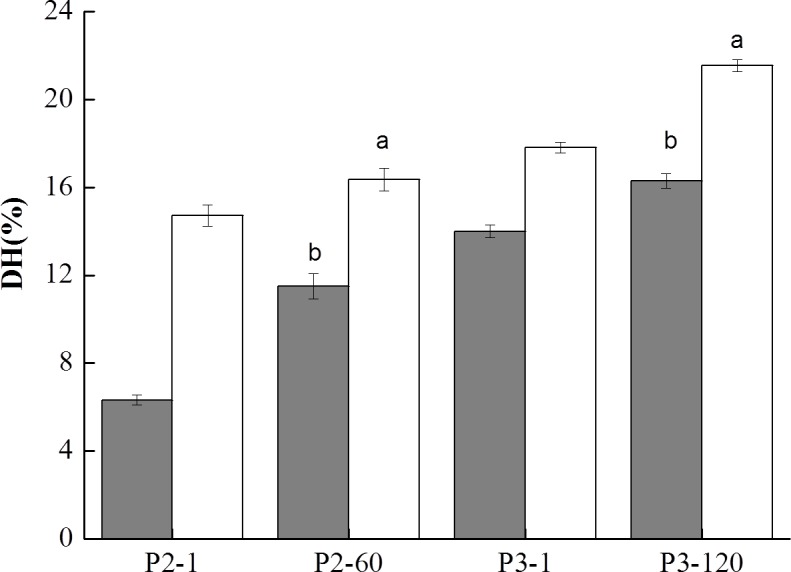
Degree of hydrolysis (DH) of digested samples at the gastric and duodenal steps for the bio-tofu with MTGase (BT-with MTGase, ■) and bio-tofu without MTGase (BT-without MTGase, □). Values are means ± SD of three independent experiments (n = 3).Different letters at the top of the bars indicate significant difference (P < 0.05) between dairy samples at the end of each digestion phase.